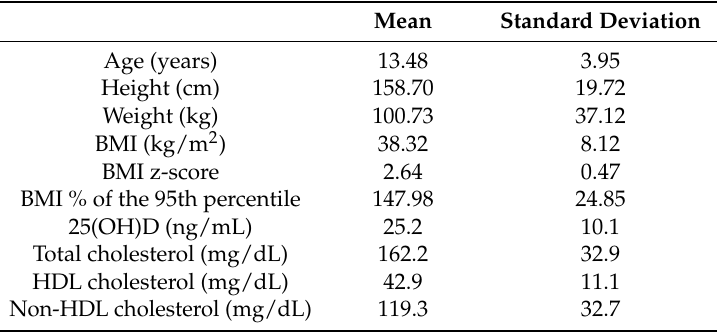
Table 1. Demographic and laboratory characteristics of study subjects.